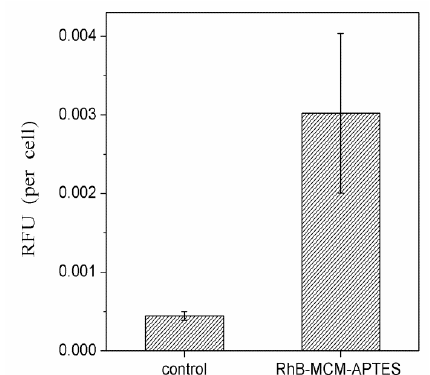
Figure 5. Proliferation of MEF adherent cells treated for 24 h with irinotecan, irinotecan loaded on silica-type carriers and drug-free mesoporous MCM-41-type supports. The tests were performed after the cease of cell exposure to the drug (t = 0 h) (A) and at 24 h after the cease of cell exposure to the drug (t = 24 h) (B).